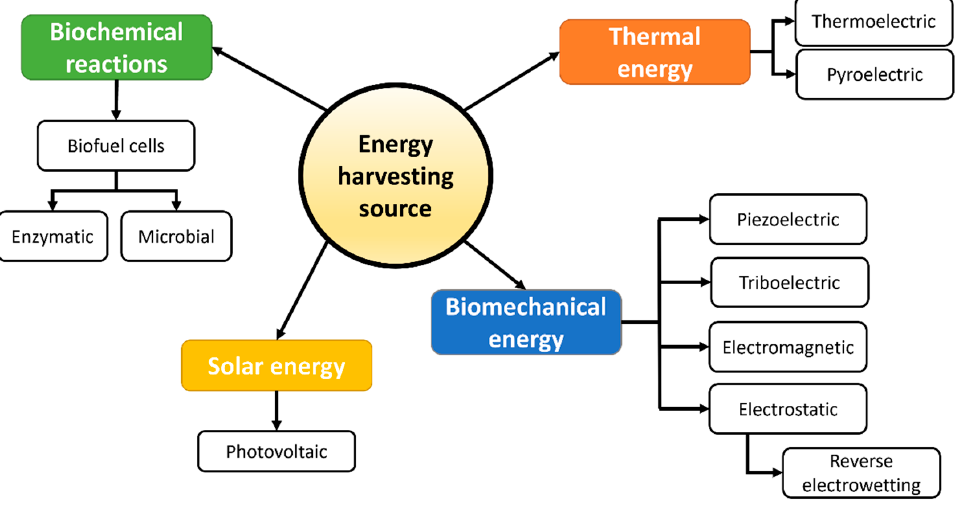
Figure 1. Energy conversion methods based on applied physical principles.